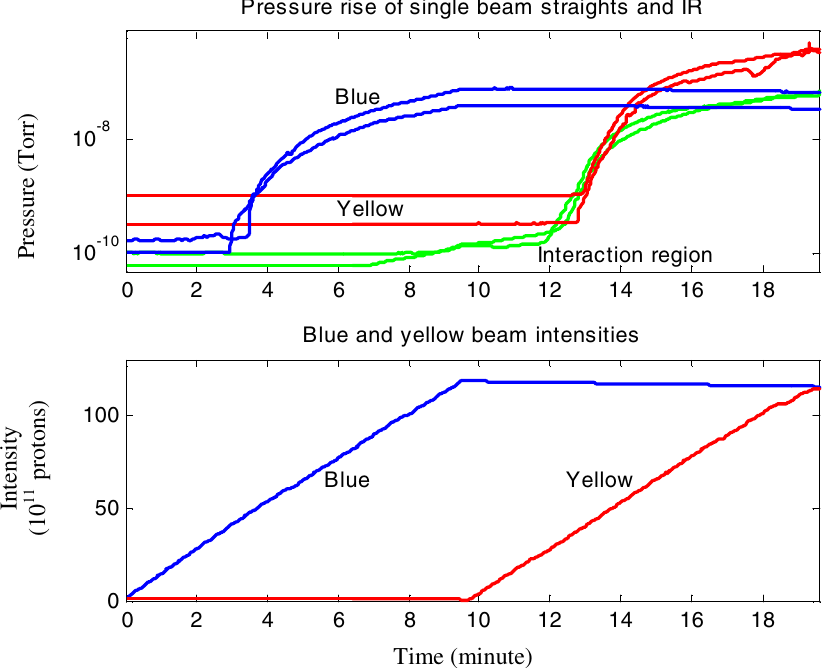
FIG. 5. (Color) Typical electron cloud induced pressure rise in blue and yellow single beam straight sections and interaction regions. The single beam straight sections are 34 m long, and the interaction region is 17 m long. Pressure rise in two locations are shown for each type of straight sections. It can be seen that for blue and yellow single beam pipes, electron cloud induced pressure rise starts at 50 (cid:3) 10 11 protons, and for interaction regions it starts at about 150 (cid:3) 10 11 protons. The beam injection is in the 110-bunch mode (bunch spacing of 108 ns), and the charge per bunch is 1 : 1 (cid:3) 10 11